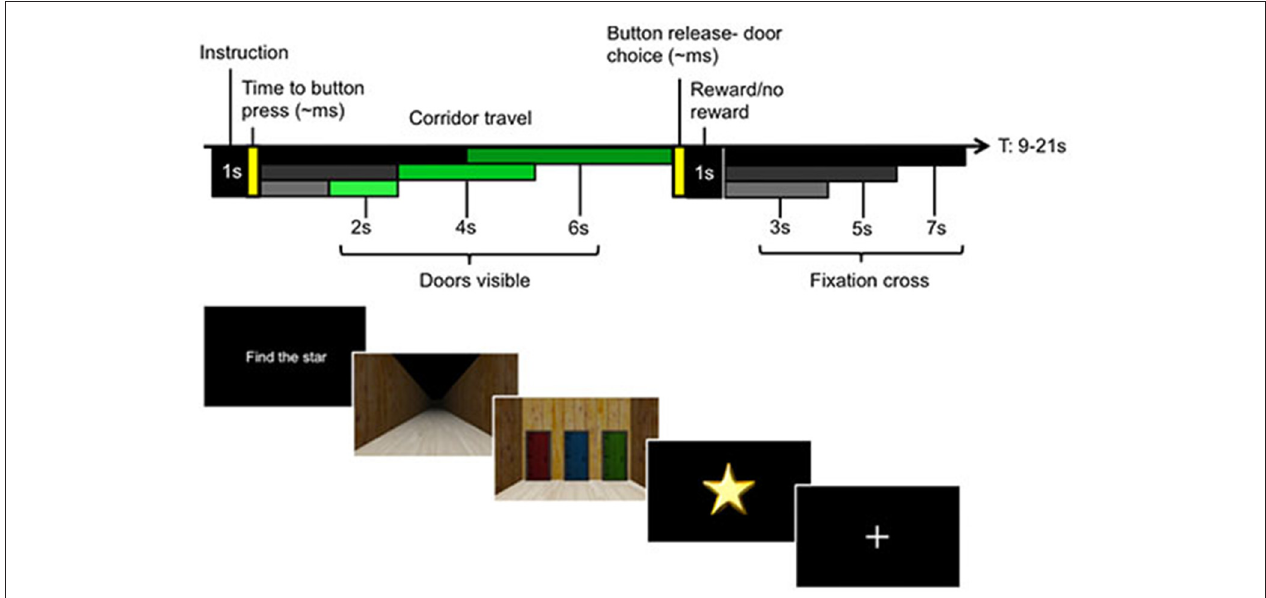
FIGURE 1 | Experimental paradigm with single trial structure (upper panel) and participant screen views in the virtual environment (lower panel). Each trial began with an instruction screen. In Instructed trials, this told participants which color door to select, e.g., “Choose green”. In Voluntary trials, participants were told to “Find the star”, which allowed them to freely choose between either of the two colored doors they had not chosen on the previous trial. Instructed and Voluntary trials were interspersed to ensure that participants initiated a new decision on each trial. Participants were asked to make their choices at the start of the trial, before proceeding up a corridor. At the halfway point, the doors became visible and the position of each colored door became apparent. This enabled the participants to initiate motor preparation to choose the appropriate door at the end of the corridor. Every correct Instructed choice received a star, while stars were pseudorandomly gained in Voluntary trials. The upper left panel illustrates the different travel times to the halfway point (black to gray bars) and the travel times from halfway point to the door (dark to light green bars), equivalent to 2, 4, or 6 s. A fixation period separated each trial (jitter represented in black to gray